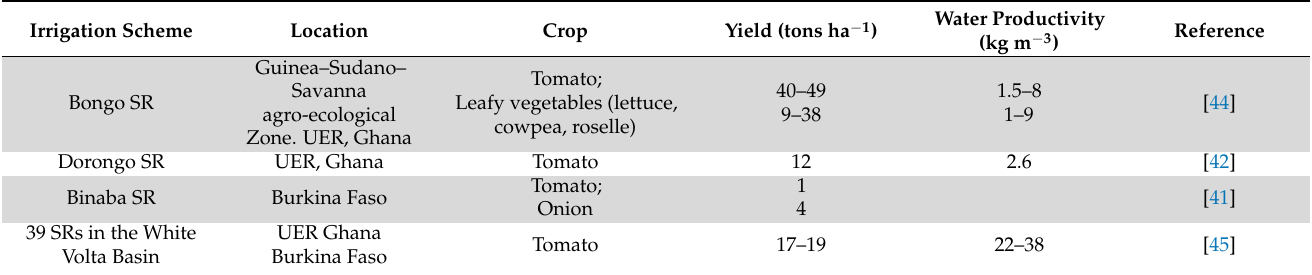
Table 4. Crop yield and water productivity of small reservoir irrigation